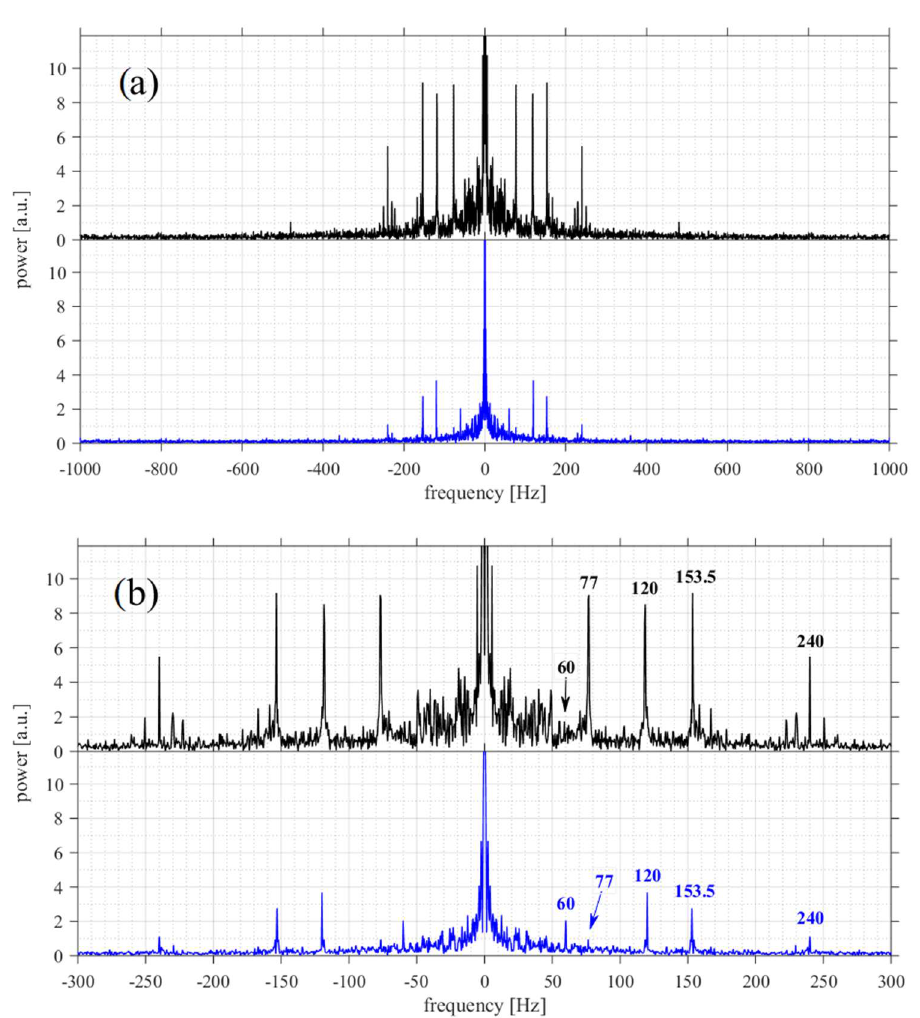
Figure 10. Fourier spectra of the two signals shown in Figure 8a, corresponding to the ‘contact’ (black) and ‘no contact’ (blue) cases. Main frequency peaks in the black plot are at 77, 120, 153.5, 240, 480 Hz. Main frequency peaks in the blue plot are at 60, 120, 153.5, 240 Hz. Sampling frequency was 5000 Hz, we show only the range of ±1000 Hz in ( a ) and ±300 Hz in ( b ) for clarity.